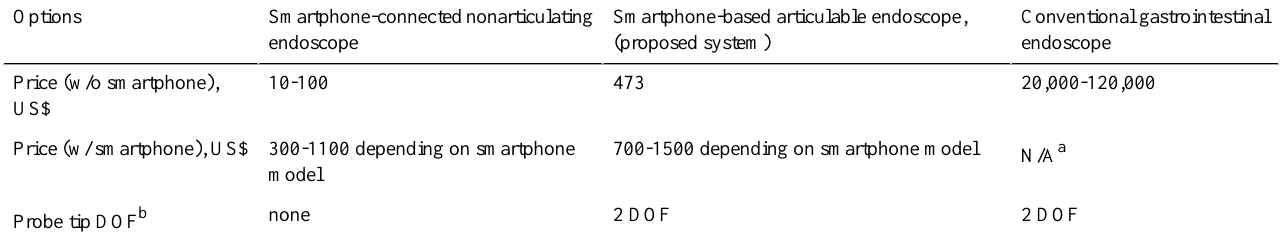
Table 2. Comparison of available